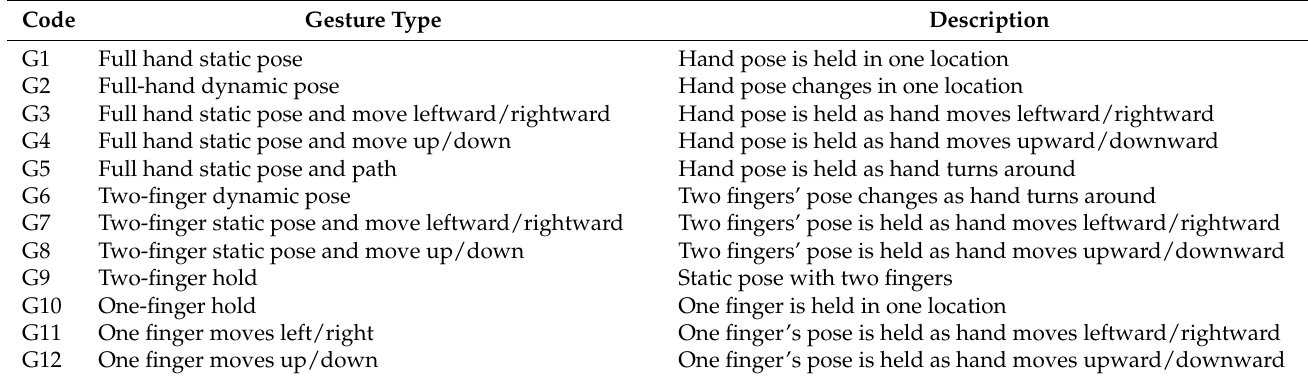
Table 2. GestDrive’s gesture codes, types and description, adapted from